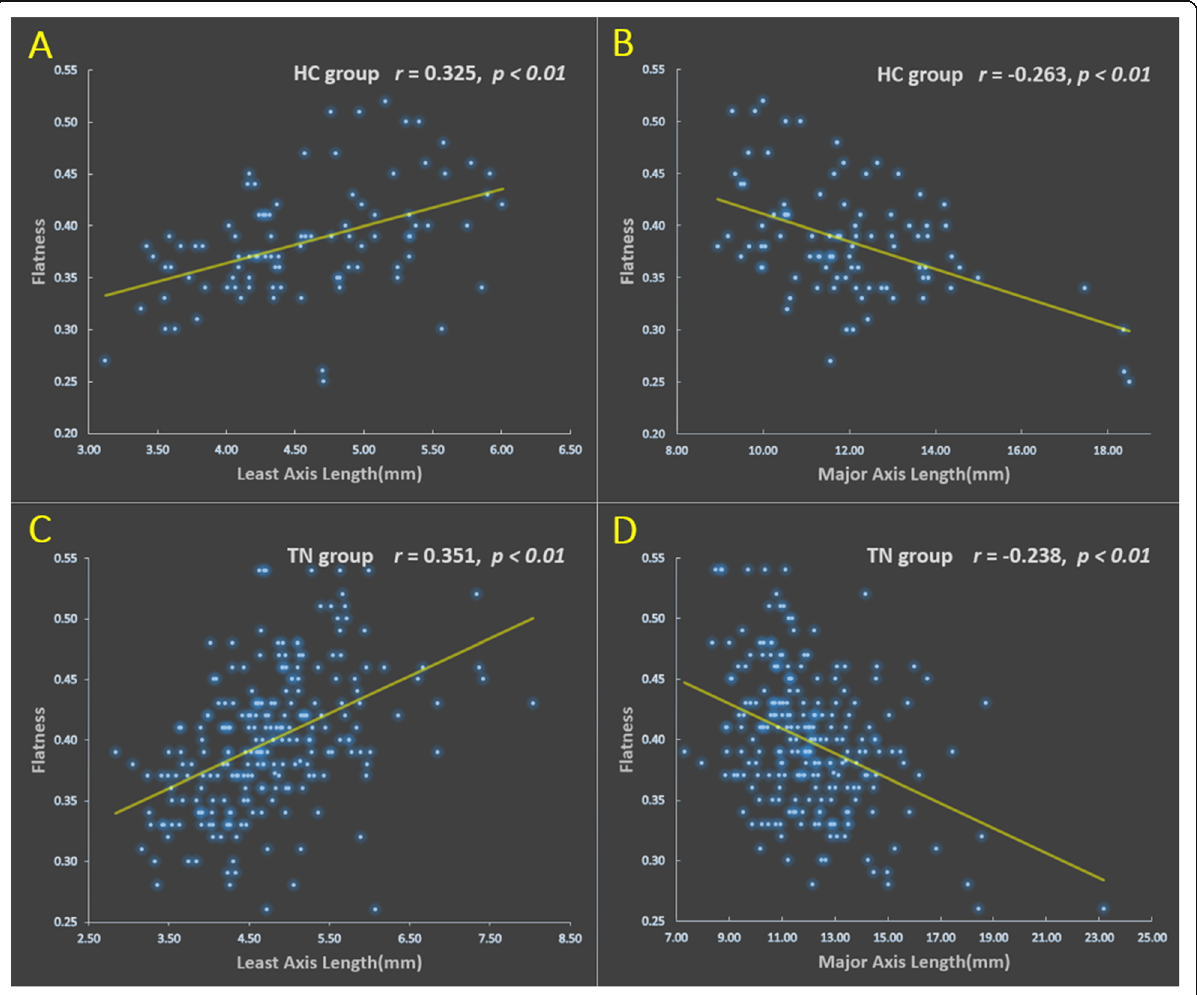
Fig. 3 Scatter plot of correlation coefficient of flatness. ( A ) Scatter plots of the flatness positively correlated with the least axis length in the HC group (r = 0.325, P < 0.01). ( B ) Scatter plots of the flatness negatively correlated with the major axis length in the HC group (r = -0.263, P < 0.01). ( C ) Scatter plots of the flatness positively correlated with the least axis length in the TN group (r = 0.351, P < 0.01). ( D ) Scatter plots of the flatness negatively correlated with the major axis length in the TN group (r = -0.238, P <